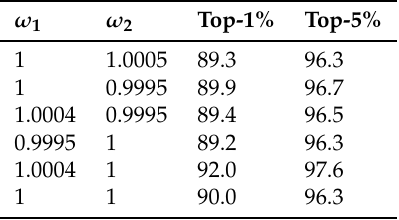
Table 9. Speaker identification results on the VoxCeleb1 dataset with different weight positions (higher is better).